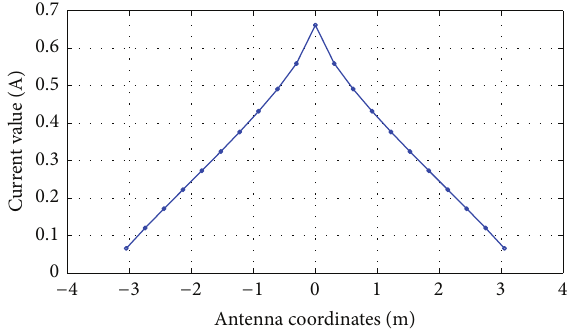
Figure 2: Current distribution on the antenna